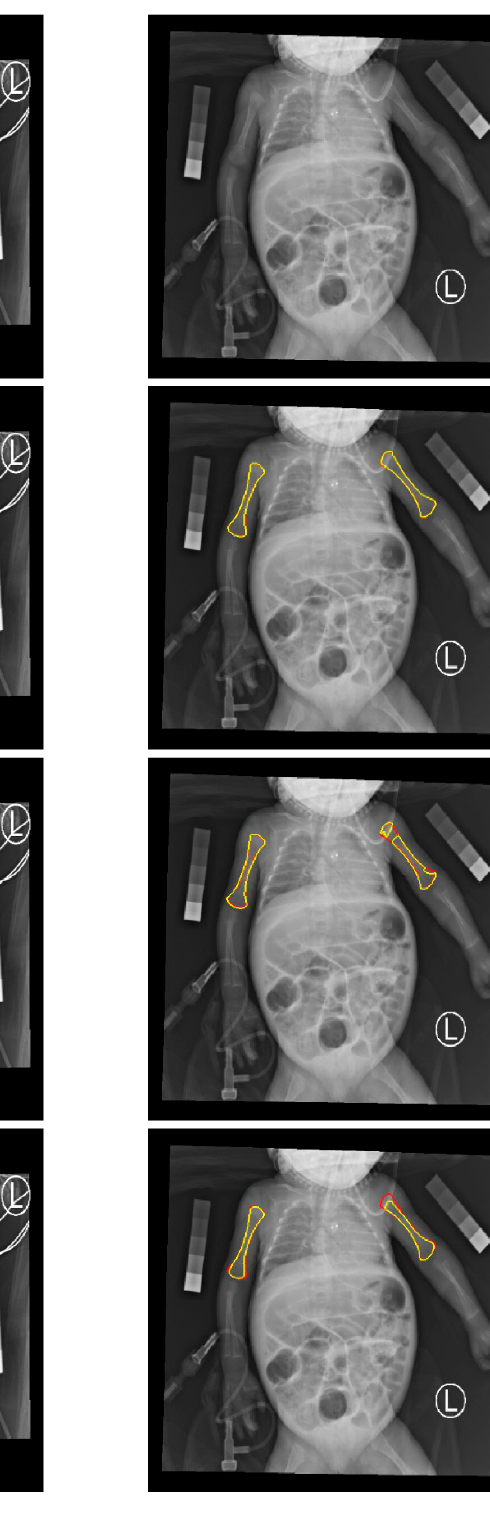
Figure 8. Visual comparison of the humerus segmentation results. The first row shows two examples of the original image. The second, third, and fourth rows represent the segmentation results of the proposed method, U-net, and AE, respectively. The ground truth contours are in red, and segmented contours (in yellow) of the automatic method overlay on the ground truth contours.